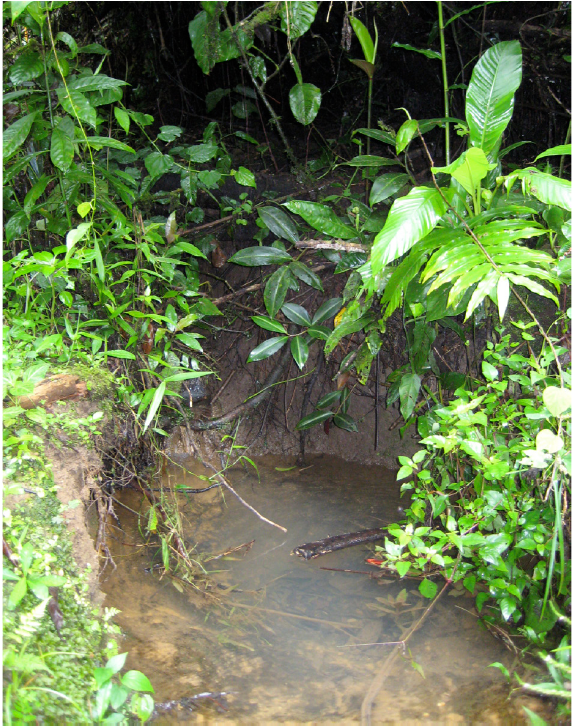
Figure 2. Capture site of Ichthyomys tweedii at Quebrada Wilson, Las Cruces Biological Station, San Vito, Puntarenas Province, Costa Rica. See methods for detailed description of the physical charac- teristics of the stream at the time of capture in 2008. Table 1. External, cranial, and dental measurements in mm of Tweedy’s Crab-eating Rat Ichthyomys tweedii (MNCR-M2106) collected in Quebrada Wilson, Las Cruces Biological Station, San Vito, Puntarenas Province, Costa Rica, and comparison to the previously